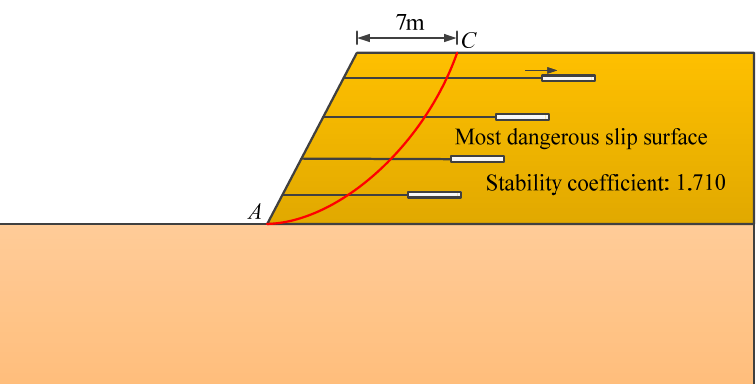
Figure 18. Example 1 calculation results of the stability of this method. (2) Strength reduction method